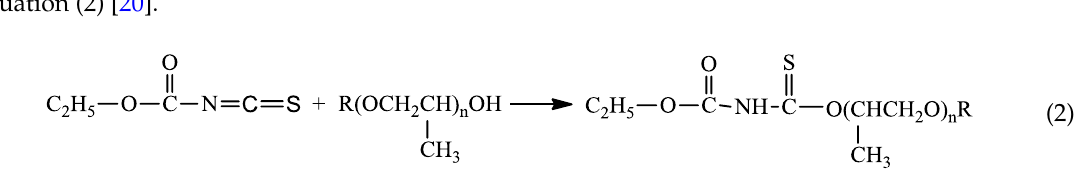
Figure 1. Diagrammatic sketch of the frothing property determined by the airflow method.